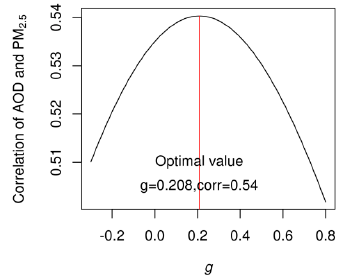
Figure 4. Optimal solution using the empirical method by varying g .